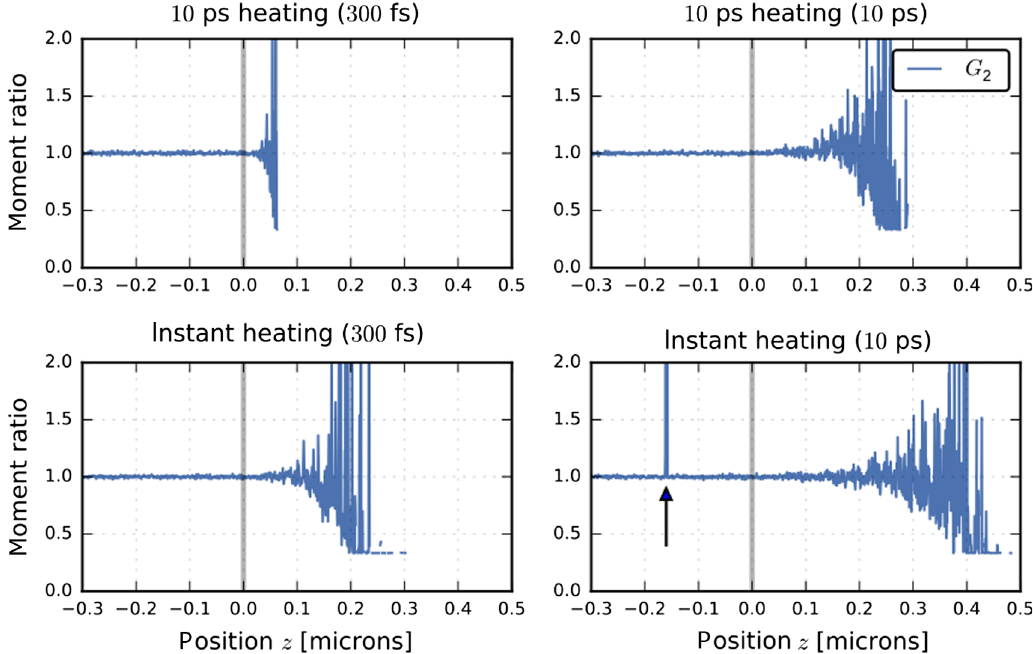
FIG. 12. Non-Maxwellian distributions. The central moment ratio G 2 ¼ h ¯ v 4 i = ð 3 h ¯ v 2 i 2 Þ is shown for H, where ¯ v ¼ v − h v i . Large fluctuations in G 2 are apparent, with a trend toward values less than unity. Also shown is a very hard collision in the lower right panel (indicated by the arrow); this feature appears only in the v 4 z